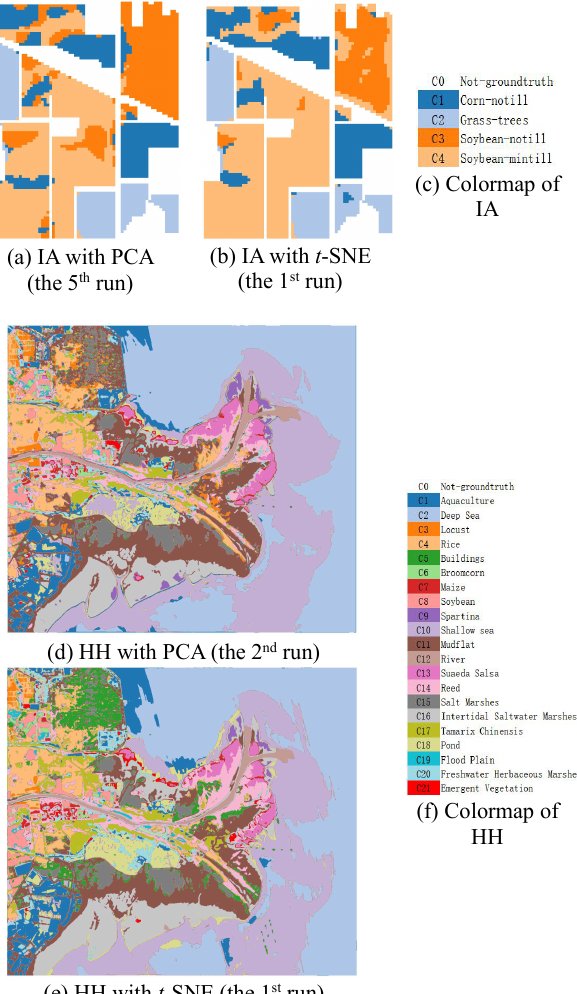
Figure 7 . Classification maps of the presented experiments using the IAand HH data